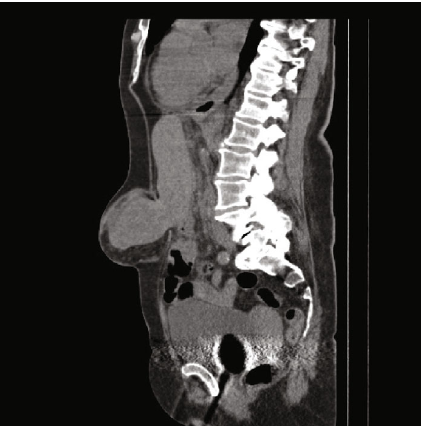
Figure 1: Sagittal section of noninjected CT abdominal scanner demonstrating herniation of liver segment III through the linea alba .